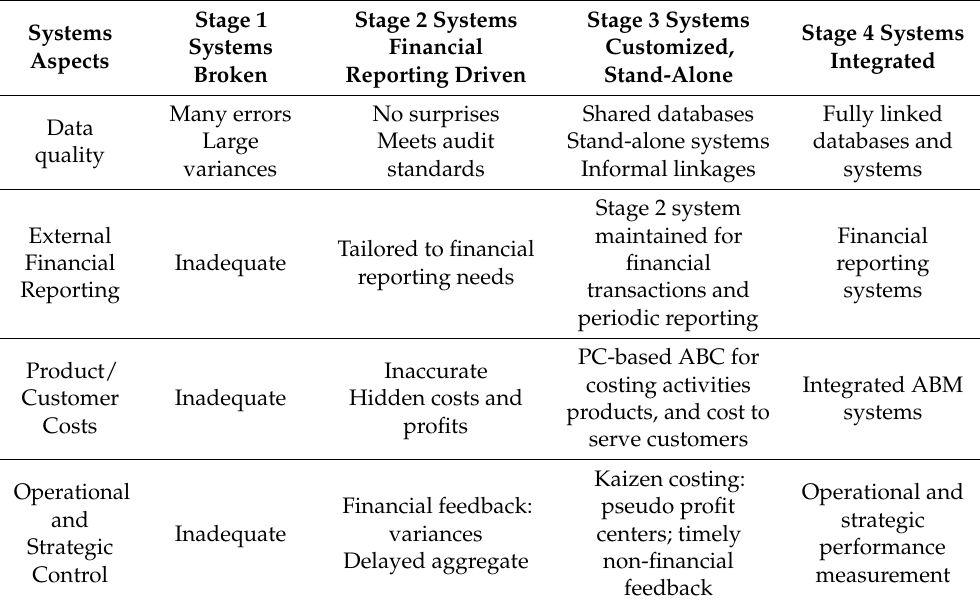
Table 4. Four-stage model of accounting information